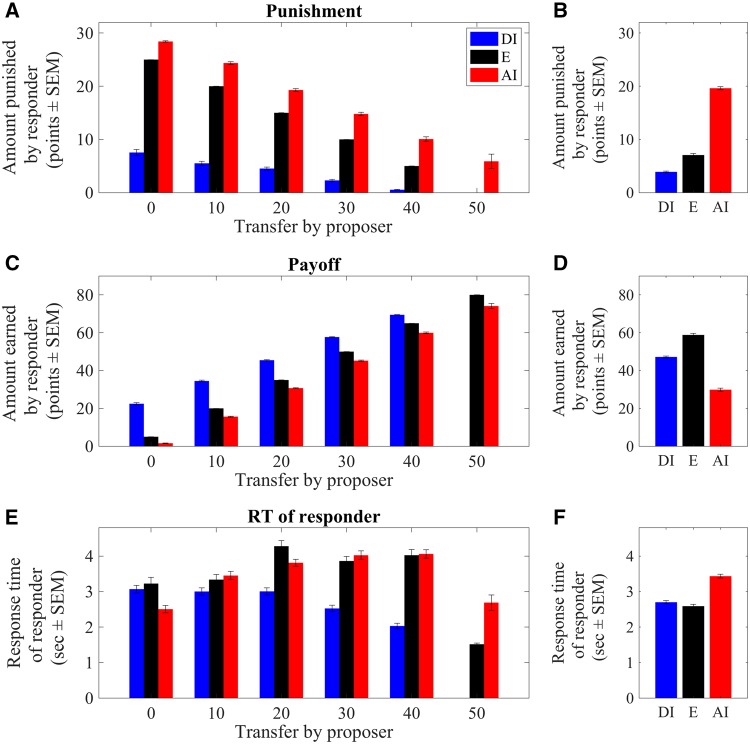
Behavioral data. (A) Responders punished the proposer less as transfer amounts of the proposer increased. (B) On average, in trials in which responders created AI they punished the proposer significantly more than in trials that resulted in E or DI. (C) Responders’ payoffs increased as transfers increased. (D) On average, given high transfer amounts combined with low punishment amounts, trials that resulted in E were associated with higher payoffs than those that resulted in AI or DI. (E) RTs of responders were highest at intermediate transfers of the proposer. (F) On average, RTs were higher for trials that resulted in AI and, to a lesser degree, DI compared to those that resulted in E. Error bars indicate standard error of the mean (SEM).